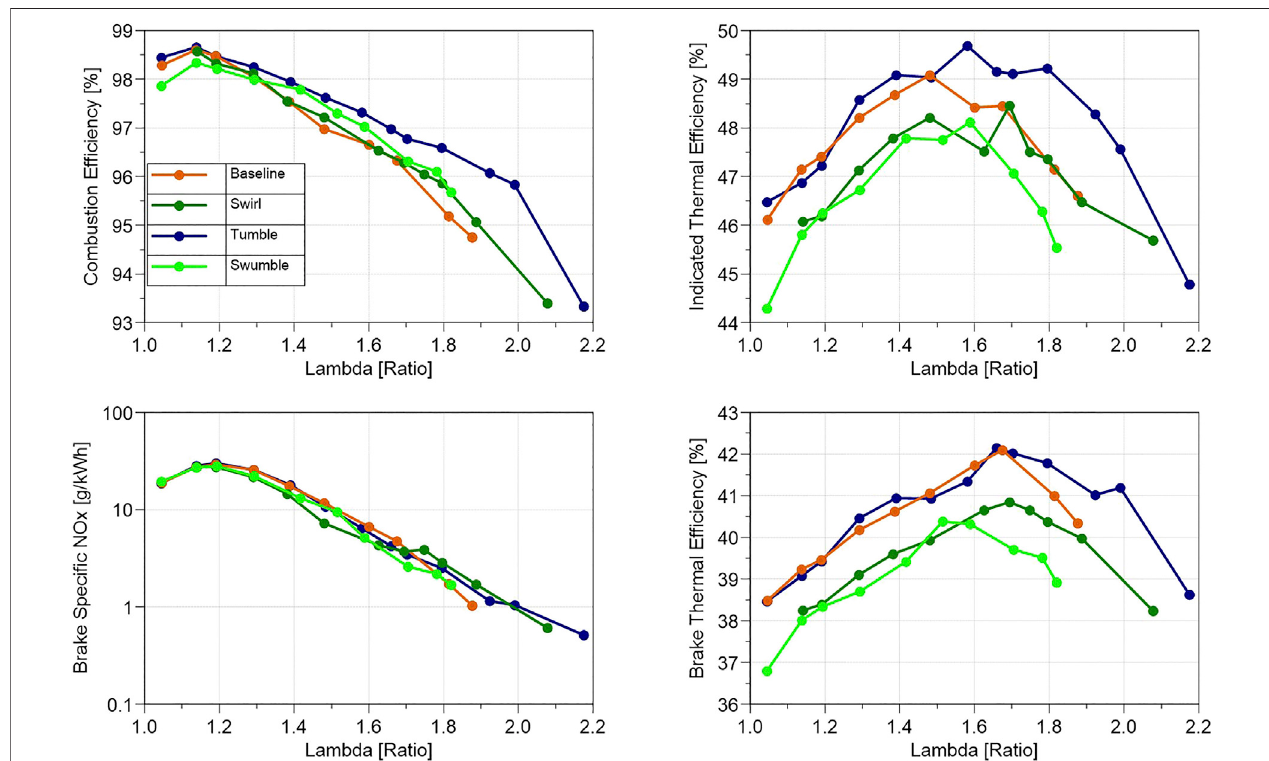
FIGURE 11 | Ef fi ciency and emissions metrics vs. lambda; 3,000 rpm, 13.5 bar IMEPg.